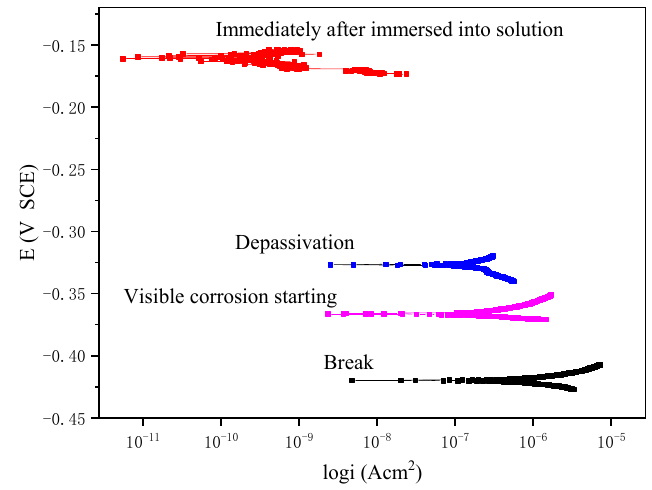
Figure 5. Polarization curves at different stages.